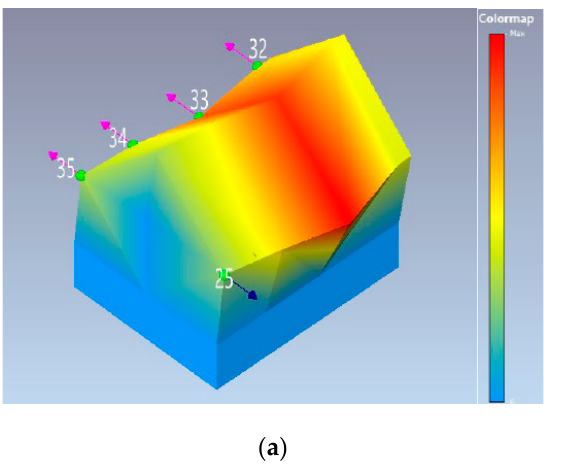
Figure 10. ( a ) 1st mode; ( b ) 2nd mode.